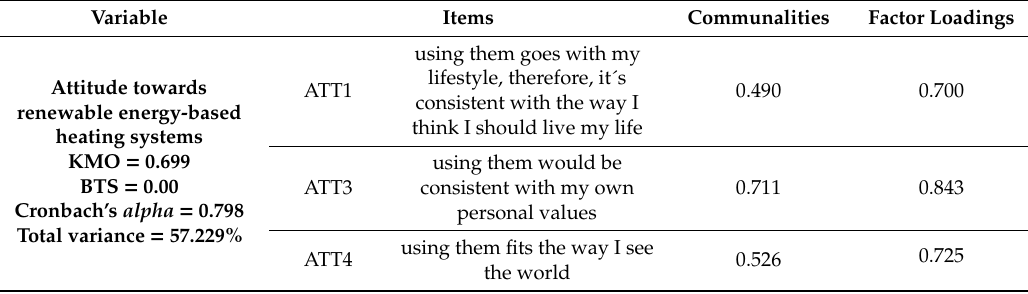
Table A1. Factor loading for ATT.